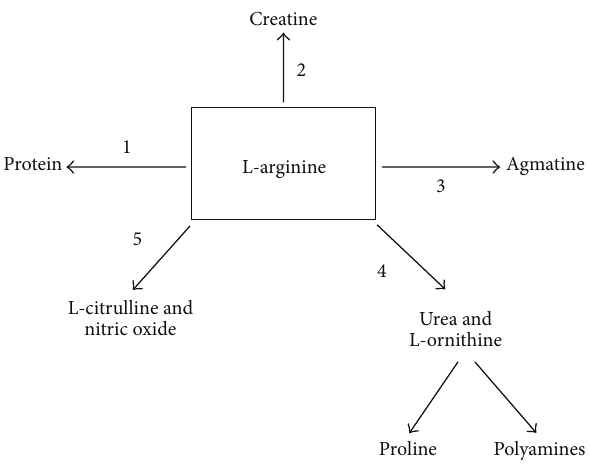
Figure 5: The arginine metabolism. Enzymes that use L-arginine as substrate are (1) arginyl-tRNA synthetase, (2) arginine:glycine amidinotransferase, (3) arginine decarboxylase, (4) arginases, and (5) NO synthases